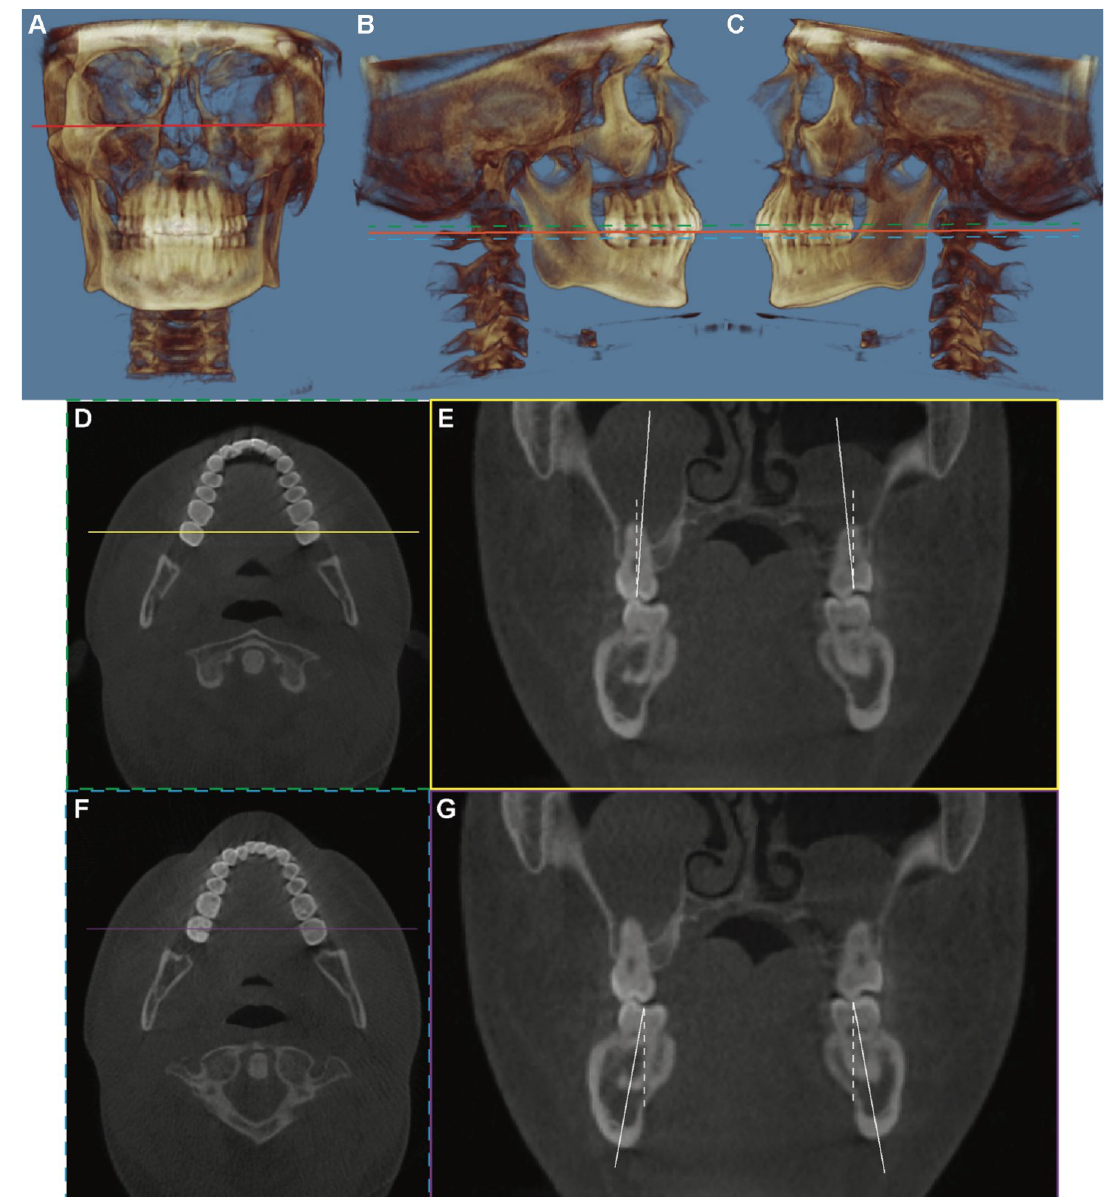
Figure 1. The demography of measurement workflow. ( A ) The CBCT image was oriented such that a line connecting the inferior border of the orbital rims (red line) was parallel to the floor. ( B , C ) The CBCT image was oriented such that the functional occlusal plane (orange line) was parallel to the floor. The axial sections of the maxillary arch (green dot line) and the mandibular arch (blue dot line) were used for sagittal guideline determination. ( D , E ) The measurement of the buccolingual inclination of the maxillary second molars. ( D ) On the axial section of the maxillary arch, the location of the coronal slide was defined as a line (yellow line) that passes through the midpoint of the mesiodistal occlusal crown width of bilateral second molars. ( E ) The coronal cross section was obtained in a 0.5 mm slice. The long axis of the tooth (solid white line) was defined as a line connecting the midpoint of the buccal and lingual cusp tips and the midpoint of the buccolingual width at the cervical base close to the furcation of the anatomic crown. The angle at which each molar’s long axis intersects a true vertical line (white dot line) was measured and represents the inclination of the tooth. ( F , G ) The measurement of the buccolingual inclination of the mandibular second molars. The axial section of the mandibular arch was used. The purple line represented the location of the coronal slide, as shown in ( G ).